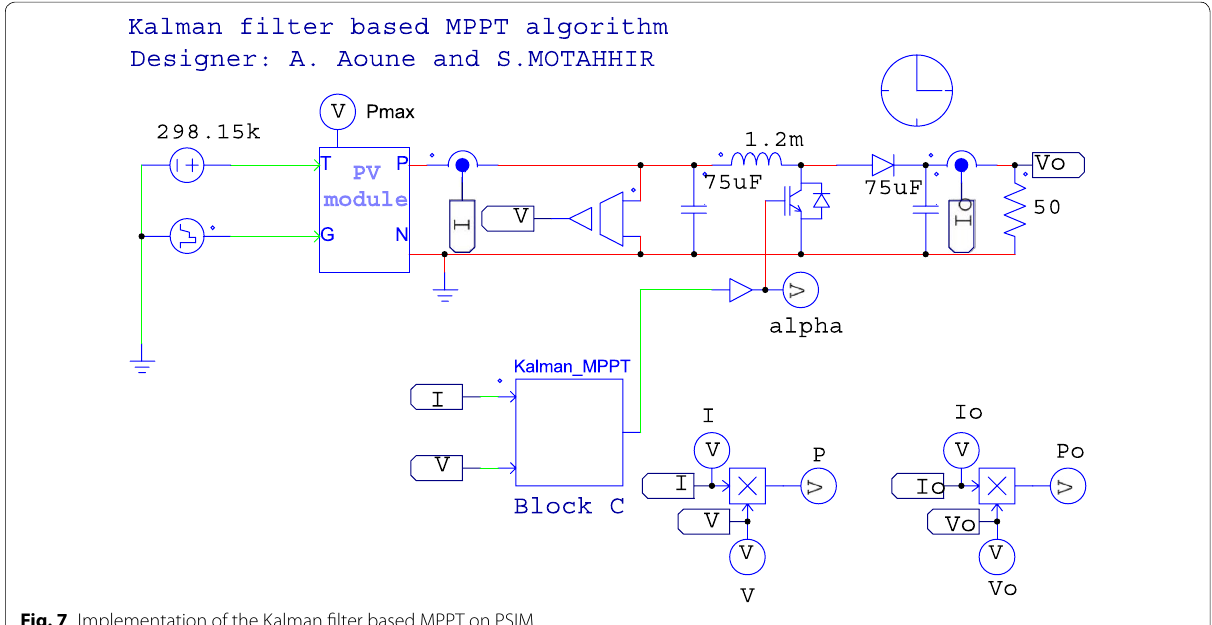
Fig. 7 Implementation of the Kalman filter based MPPT on PSIM